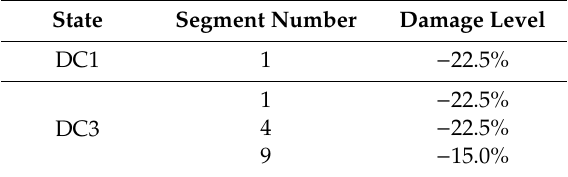
Table 3. Damage location and severity for numerical validation.